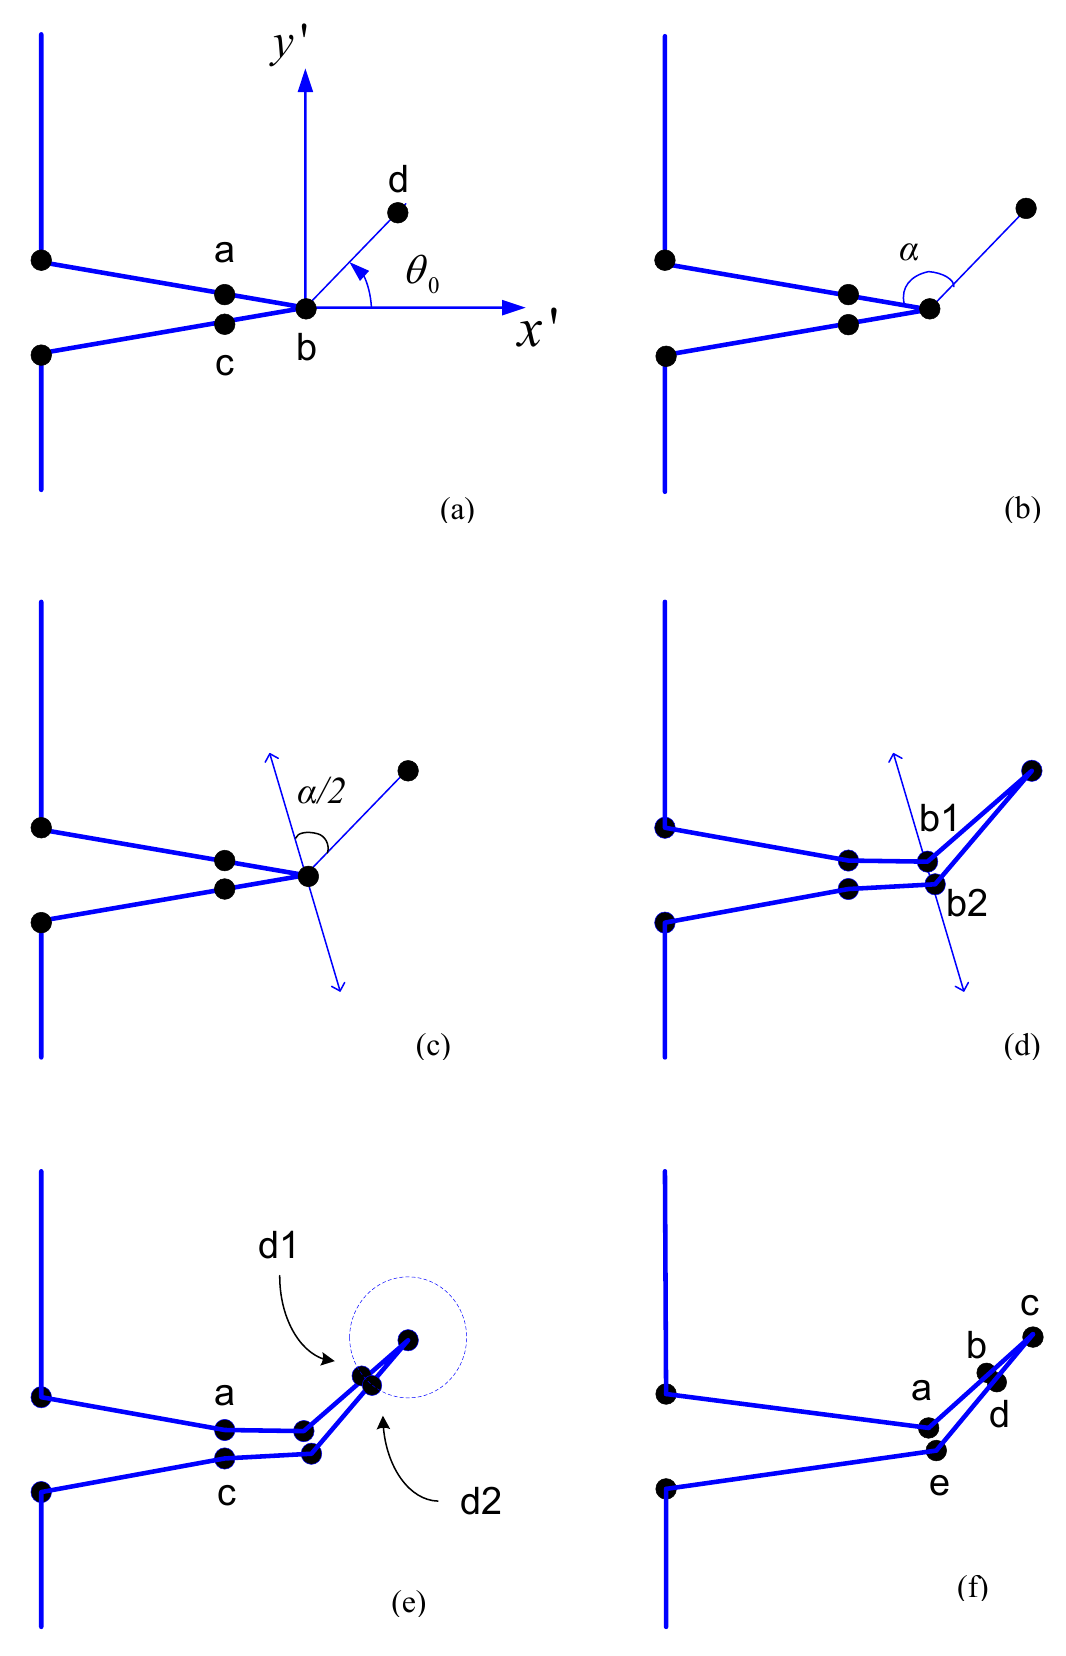
Figure 5. Procedure for splitting a crack node and updating boundary nodes. ( a ) step 1 ( b ) step 2 ( c ) step 3 ( d ) step 4 ( e ) step 5 ( f ) step 6.